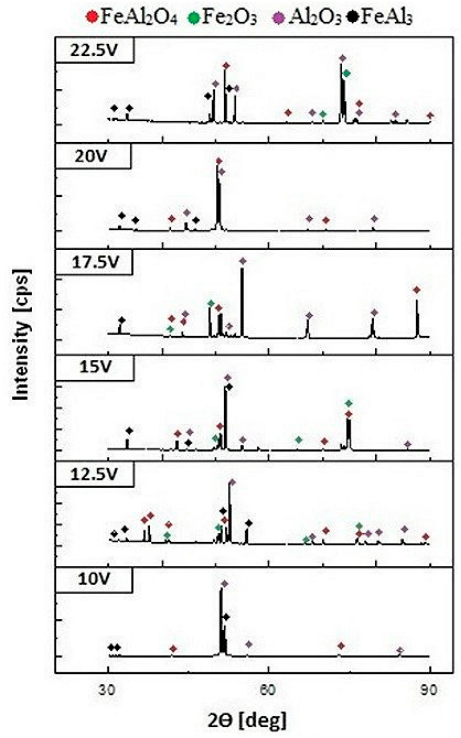
Figure 5. X-ray di ff raction (XRD) patterns of the anodic oxide formed via self-organized two-step Figure 5. X-ray diffraction (XRD) patterns of the anodic oxide formed via self-organized two-step anodization of an FeAl 3 intermetallic anodization of an FeAl 3 intermetallic alloy.